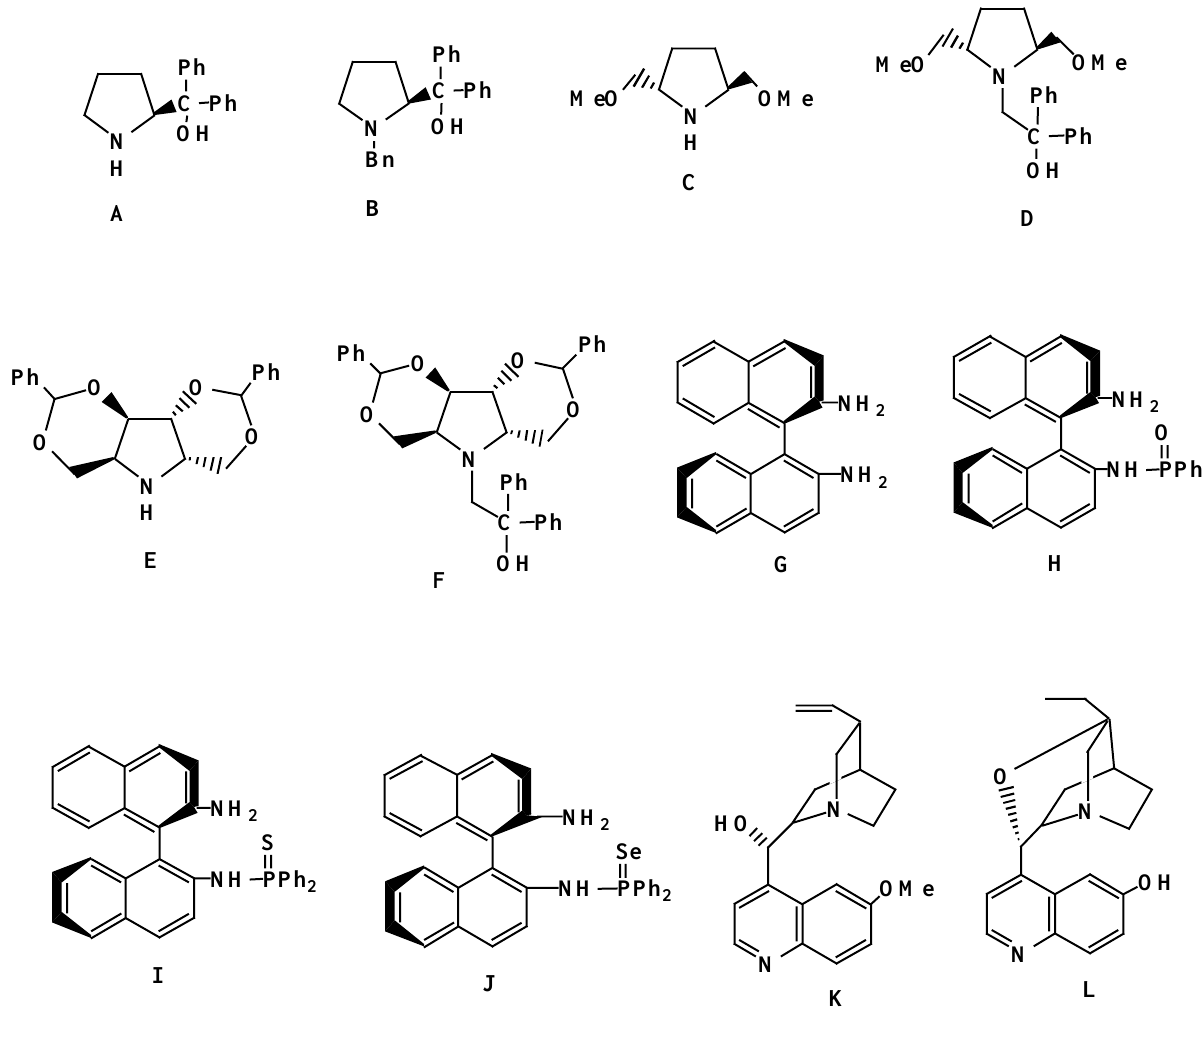
Figure 2: The chiral Lewis bases used for the Bayliss-Hillman